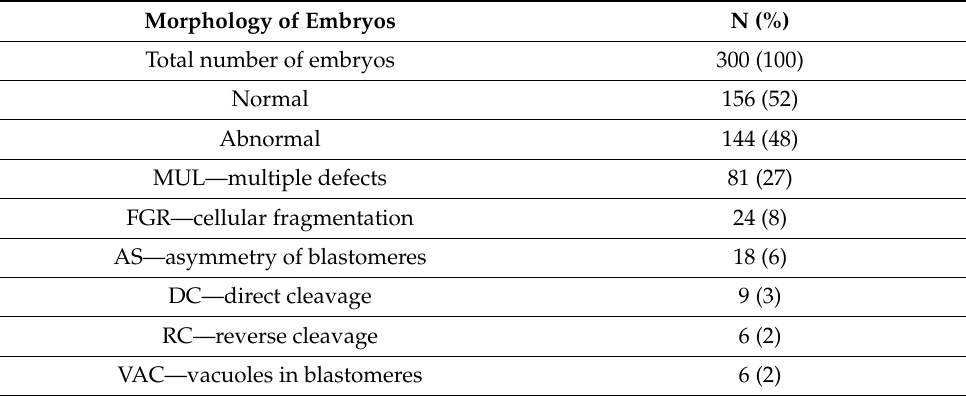
Table 1. Characterization of morphological defects in domestic cat